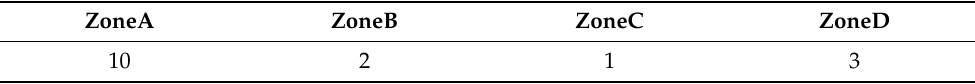
Table 3. Specified number of workers for different zones.